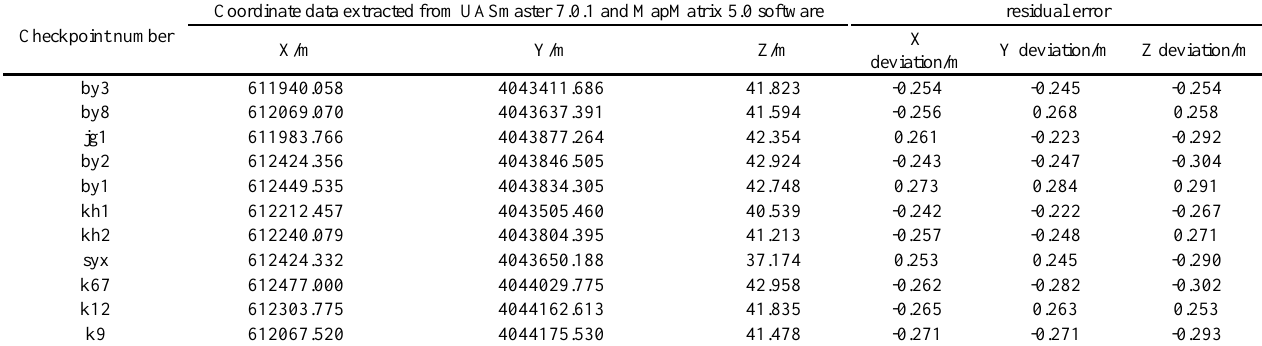
Table 6 Scheme Ⅰ experimental data